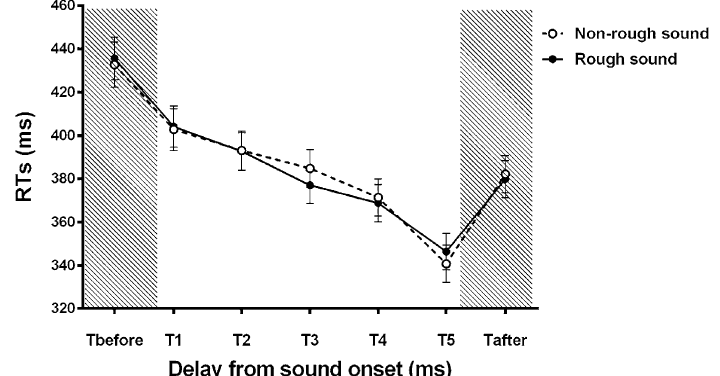
Figure 3. Auditory-tactile interaction experiment results—Analysis of mean reaction times (RTs). This figure depicts participants’ (n = 40) mean tactile reaction times (RTs ± SEM) in the rough (filled black circle) and non-rough (open circle) sound conditions, as a function of the delay between the tactile stimulation and the sound onset. The shaded regions indicate the silent periods during which the tactile stimulation occurred alone either before sound onset or after sound offset (unimodal conditions). Auditory-tactile integration is evidenced by shorter RTs; here, the first significant decrease in RTs occurred at T3 for the rough sound, and T5 for the non-rough sound, with T3 corresponding to a farther perceived sound distance. It means that efficient auditory- tactile integration occurred at a farther sound distance from the body for rough sound, thus suggesting a larger PPS for rough